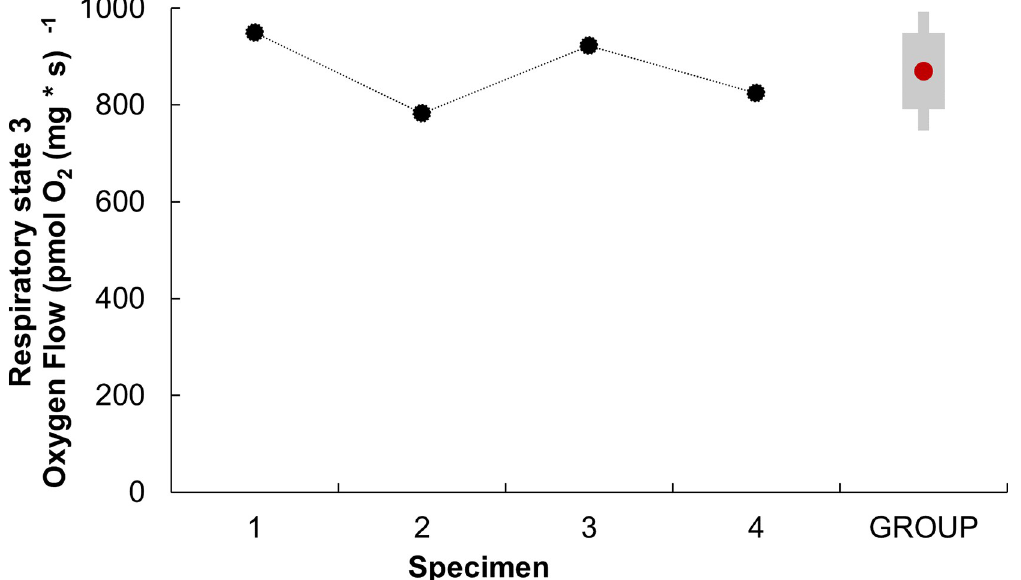
Fig 2. Respiratory parameter of state 3 (S3) of isolated mitochondria from the systemic heart of Octopus maya . The S3 of the systemic heart mitochondria was obtained from the correction of the respiratory state 3’ (S3’) and ROX (S3 = S3’-ROX). To obtain S3’, adenosine diphosphate (ADP) was added at a final concentration of 1.25 mM. The S3 was obtained individually (black dots) for each adult O . maya specimens (N = 4, mean weight 1 348 ± 263.49 g) using a mitochondrial concentration of 377 ± 0.02 μ g ml -1 . GROUP; represents the mean S3 value of the four specimens (red dot), ± SD (gray box).